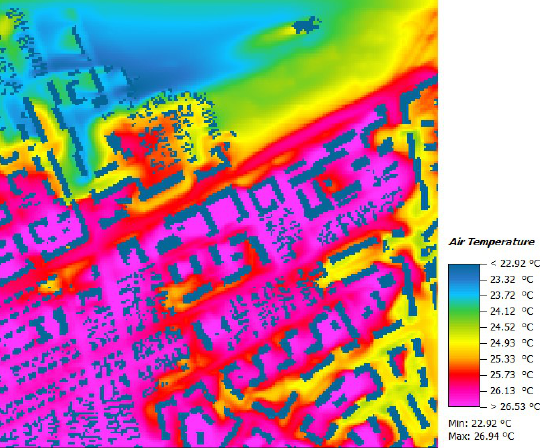
Figure 3. The 3D Air temperatures at the elevation z=1.4 m